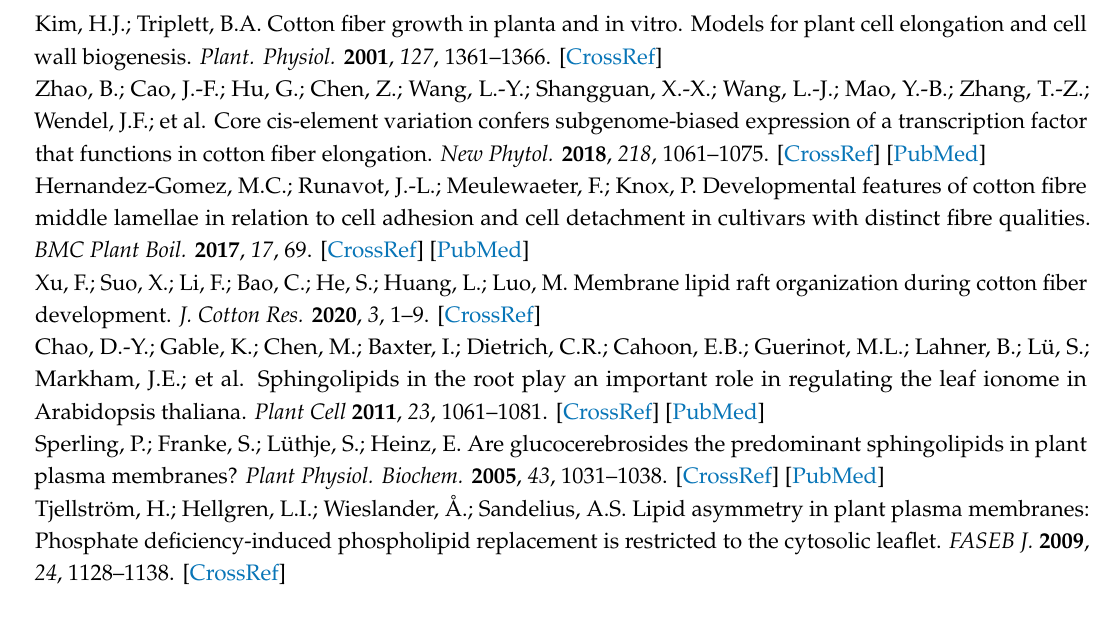
Figure S1 : Protein domain enrichment analysis of the DEPs in the control and the FB1 samples; Table S1: Primer sequences for semi-quantitative PCR; Table S2: Individual sphingolipid content of control and the FB1 sample; Table S3: The list of all proteins identified using LC-MS / MS in control and the FB1 samples; and Table S4: The list of all DEPs in the control and the FB1